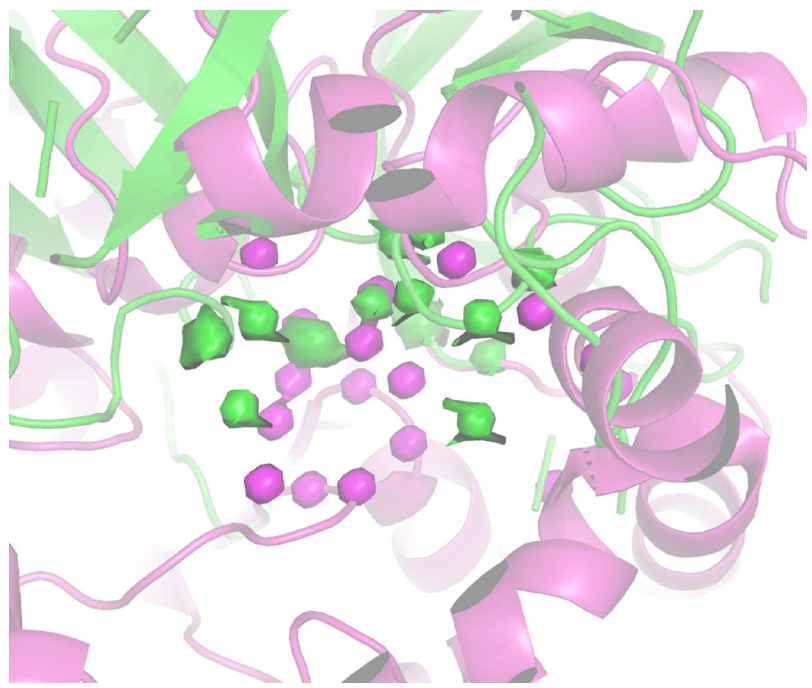
Figure 8. Comparison of 1GVK (protease) and 2W22 (lipase) active site H-bond donor pseudo-MIFs. The structures of 1GVK and 2W22 are represented in green and magenta cartoons respectively. 1GVK pseudo-MIFs are represented as green surfaces. 2W22 pseudo-MIFs are represented as magenta surfaces.